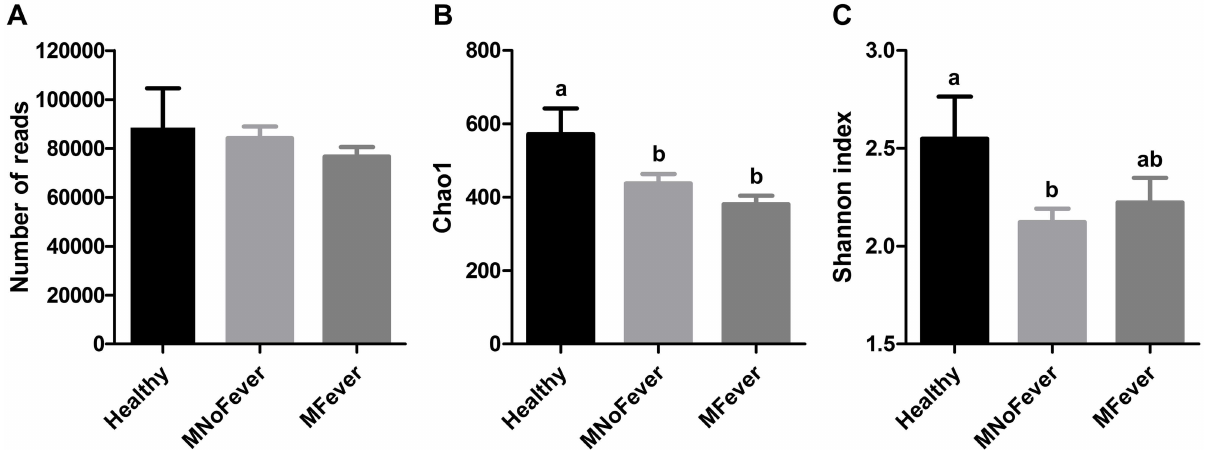
Fig 1. Diversity of uterine microbiota from the Healthy (n = 11), MNoFever (n = 12), and MFever (n = 11) groups. (A) Number of reads. There is no significant differenceamong groups. (B) Chao1 richness index. Chao1 richness estimates the total number of species in a sample based on the number of singletonand doubleton taxa. (C) Shannondiversity index. Shannonindex takes into account both the species richness and evenness. Data represent the mean ± SEM. Data labeled“a” are statistically different ( P (cid:20) 0.05) from data labeled